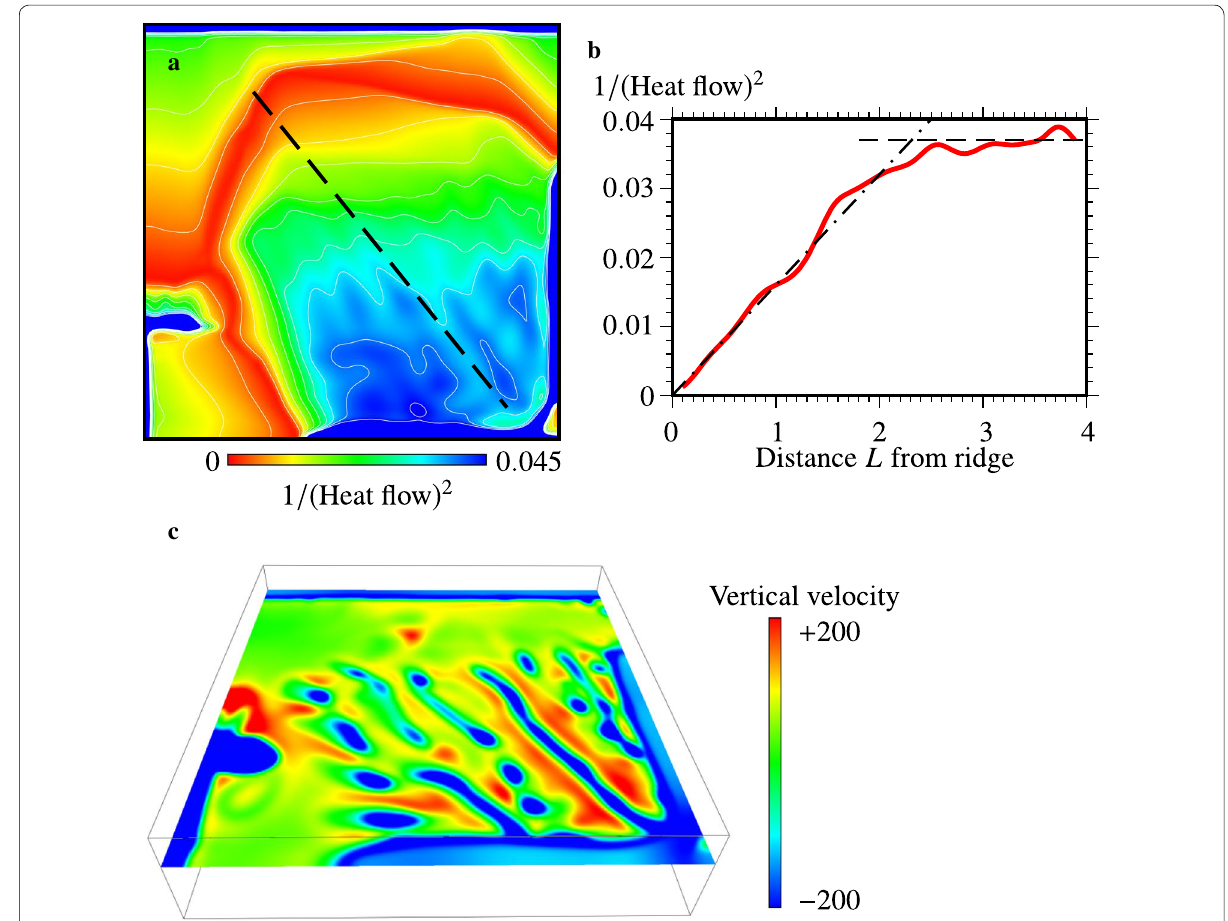
Fig. 2 The lateral variations in the surface heat flow and convecting flow structure. a The distribution of the inverse square of the surface heat flow shown in both colour and white contour lines. b The plot of the inverse square of heat flow at the surface as a function of the distance L from the divergent plate boundary (ridge) along a horizontal track indicated by the dashed line in a . Also shown by the dash-dotted line is the theoretical prediction from the half-space cooling for small L , while by the dashed line is the deviation from it for large L . c The distribution of vertical component of velocity V z on the horizontal plane at the height of z =